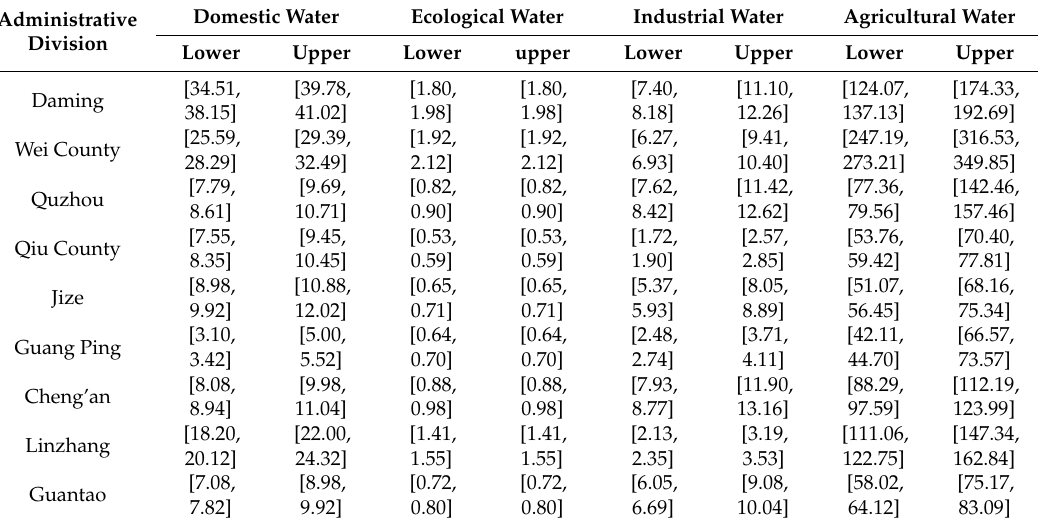
Table 1. Upper and lower limit of water demand (10 6 m 3 ).